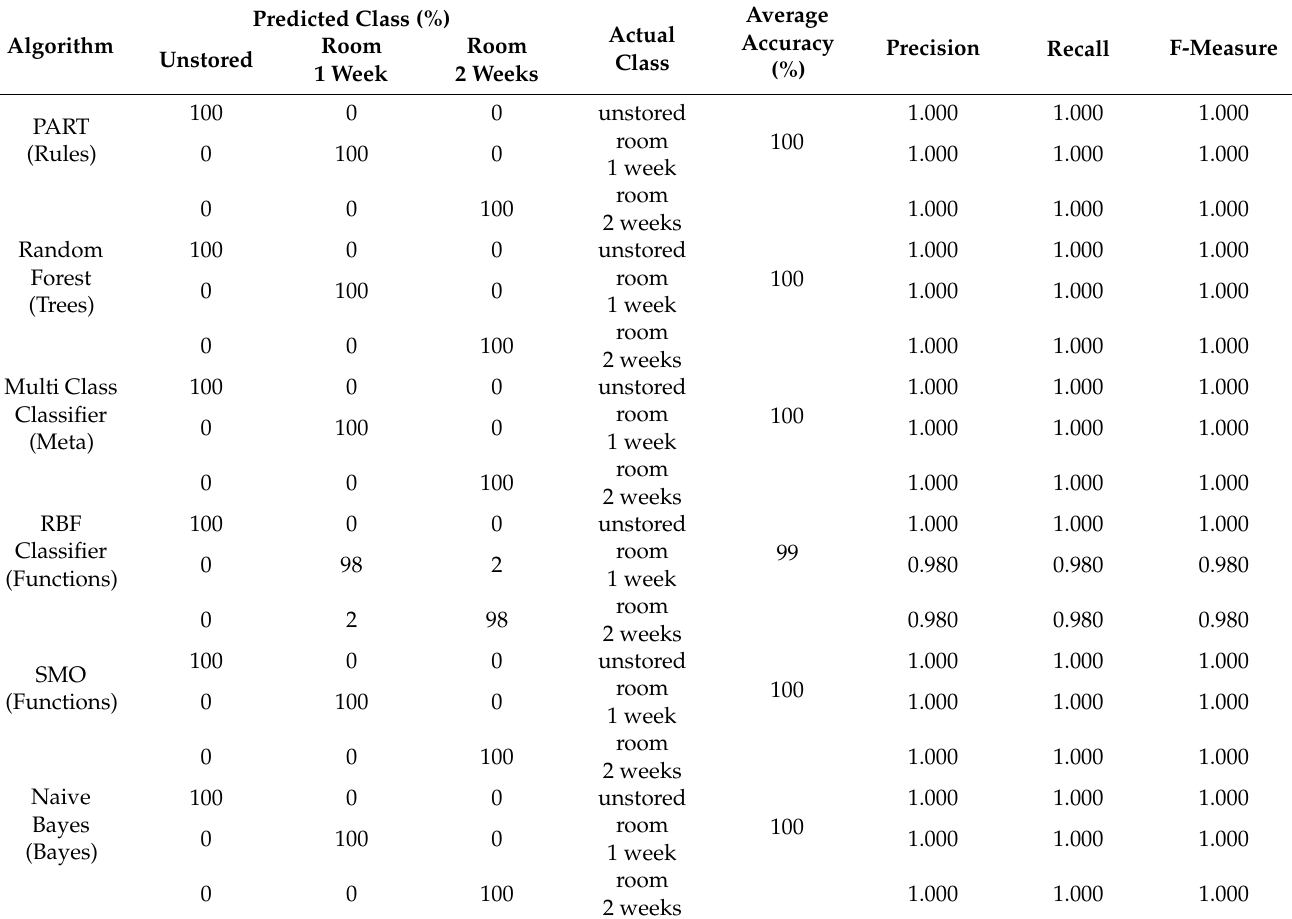
Table 1. The results of the classification of unstored red currants, and fruit stored at room temperature for one week, and stored at room temperature for two weeks based on models combining selected textures from color channels R , G , B , L , a , b , X , Y , and Z developed using machine learning algorithms from different